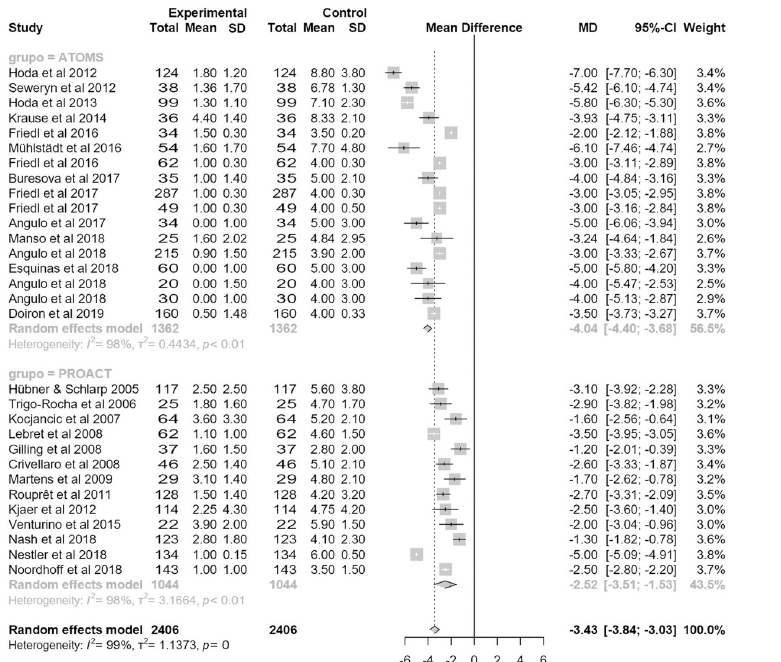
Fig 6. Forest plot of studies analyzed with differential pad-count in pads-per-day.